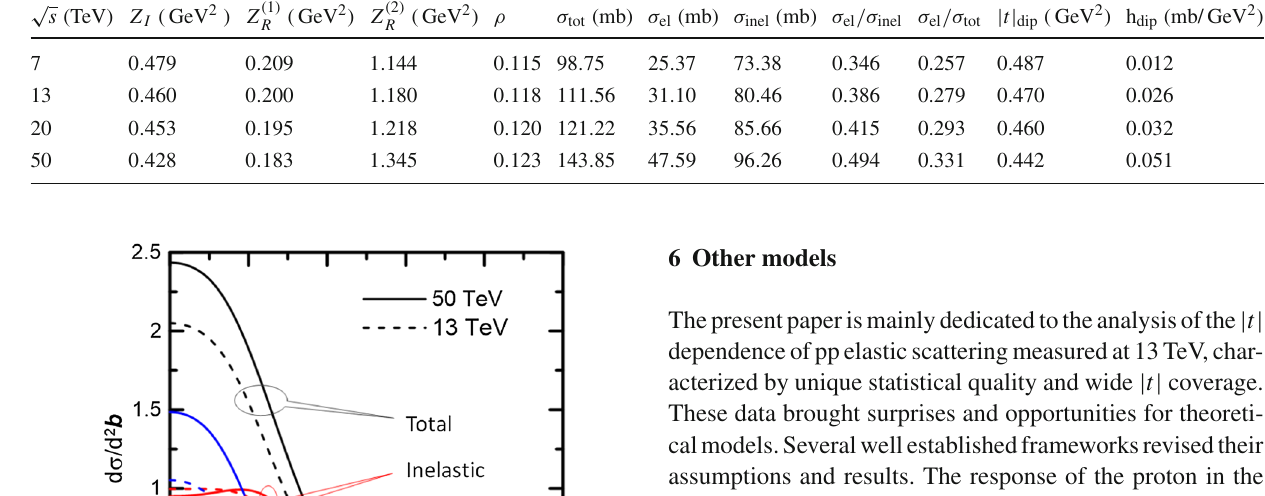
of proton and of the surrounding QCD field in the collision